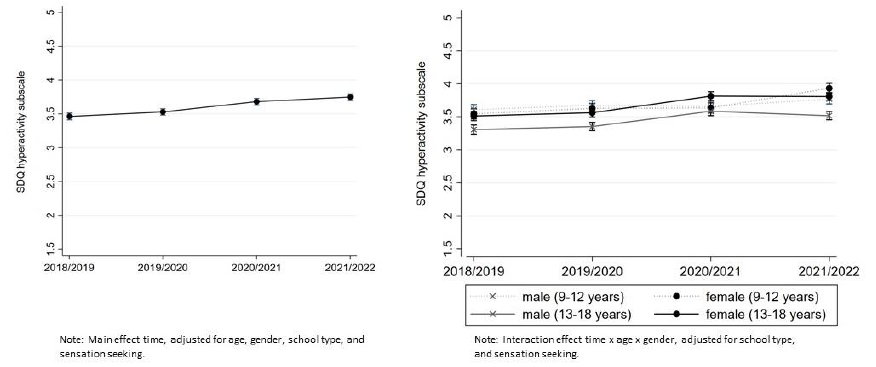
Figure 2. Mean SDQ subscale emotional problems scores from 2018–2019 to 2021–2022, cross-sectional measures, 2018–2019 and 2019–2020 pre-pandemic, 2020–2021 and 2021–2022 pandemic. The scale ranges from 0 to 5 (abnormal problem behavior).